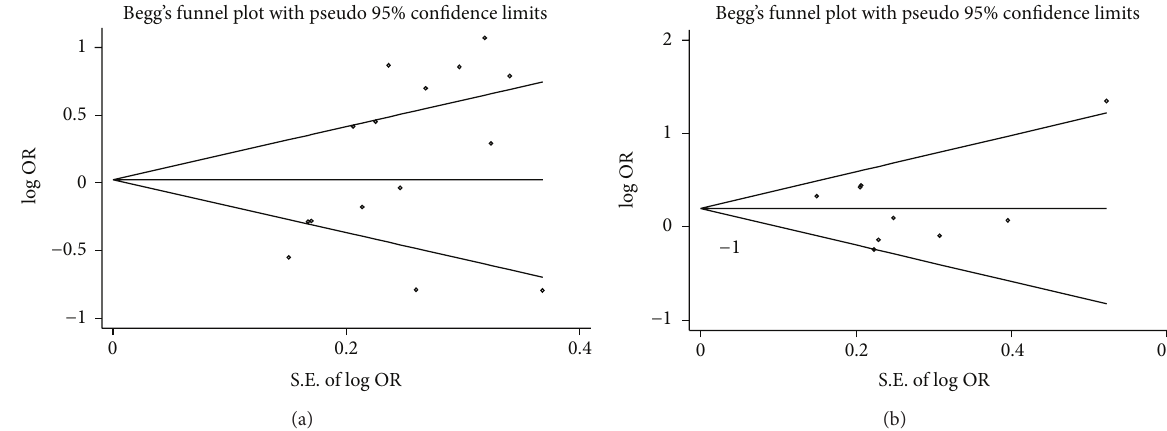
Figure 6: Begg’s funnel plots of publication bias analyses. (a) Funnel plot of GSTM1 polymorphism and risk of ARC. (b) Funnel plot of GSTT1 polymorphism and risk of